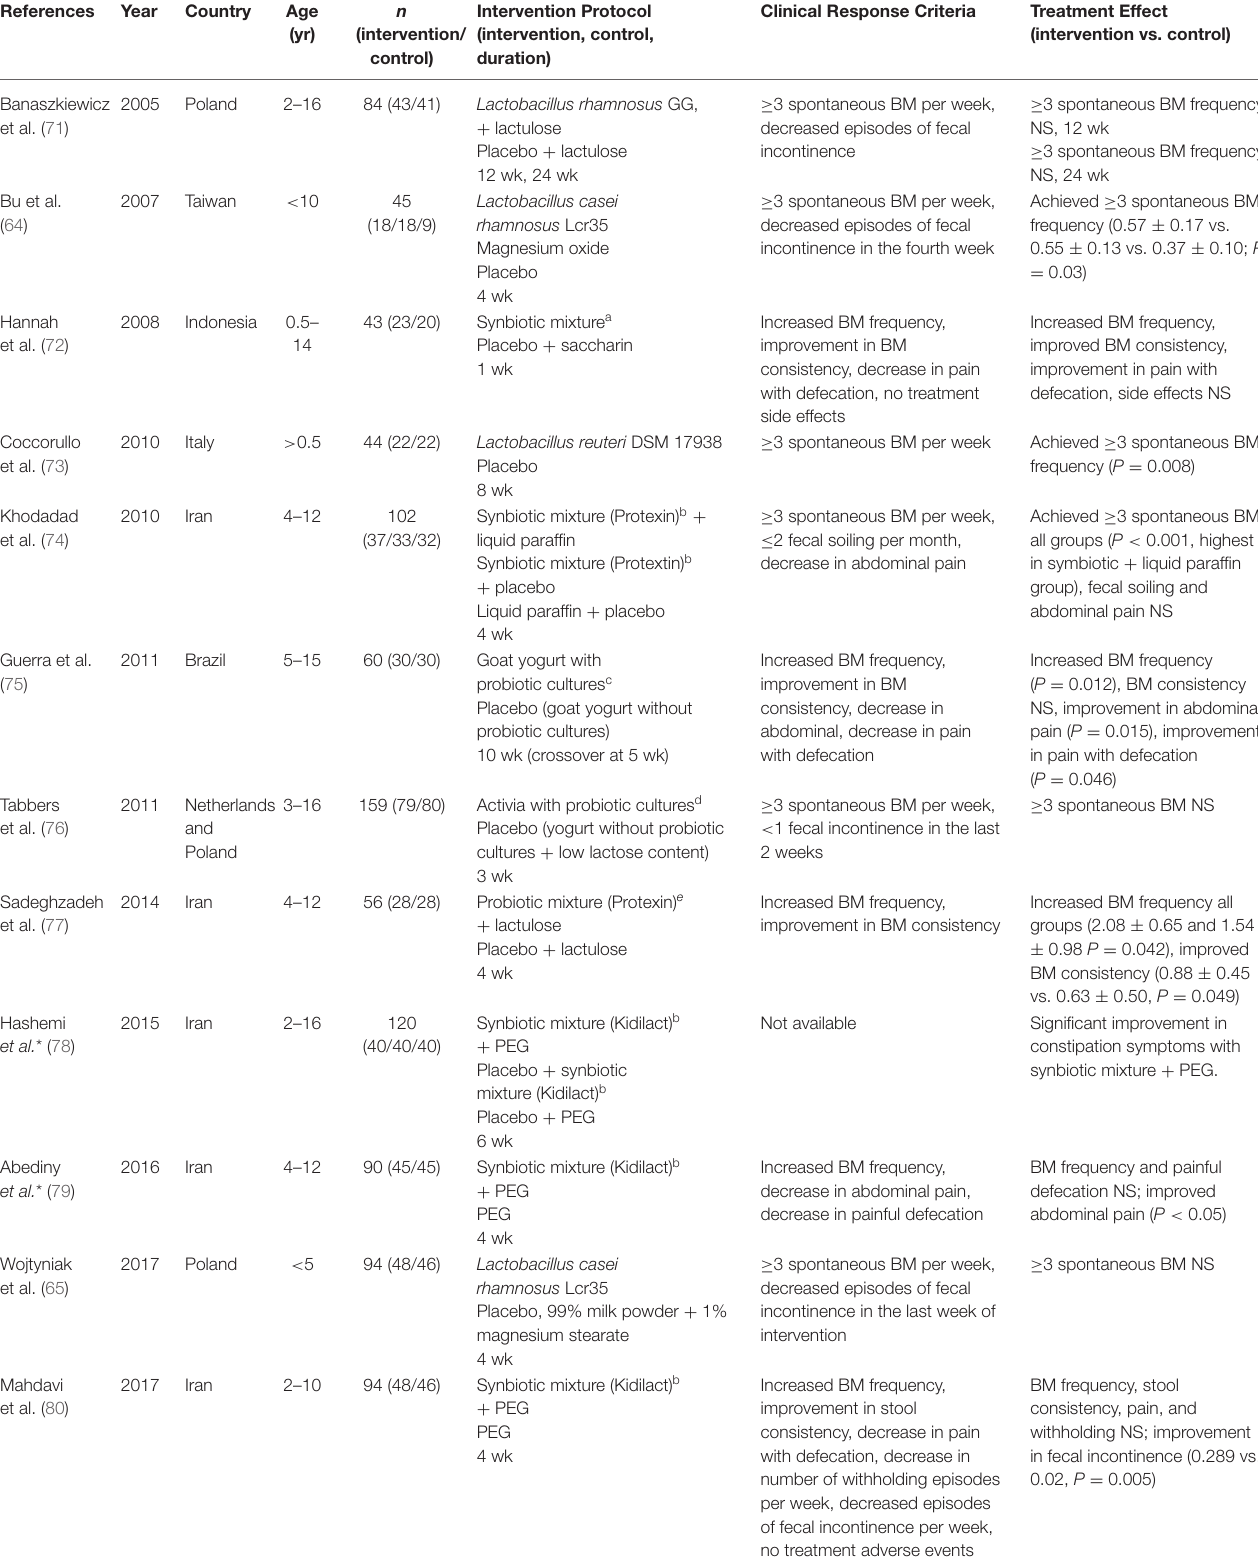
TABLE 2 | Characteristics of studies assessing the effects of probiotics on children with